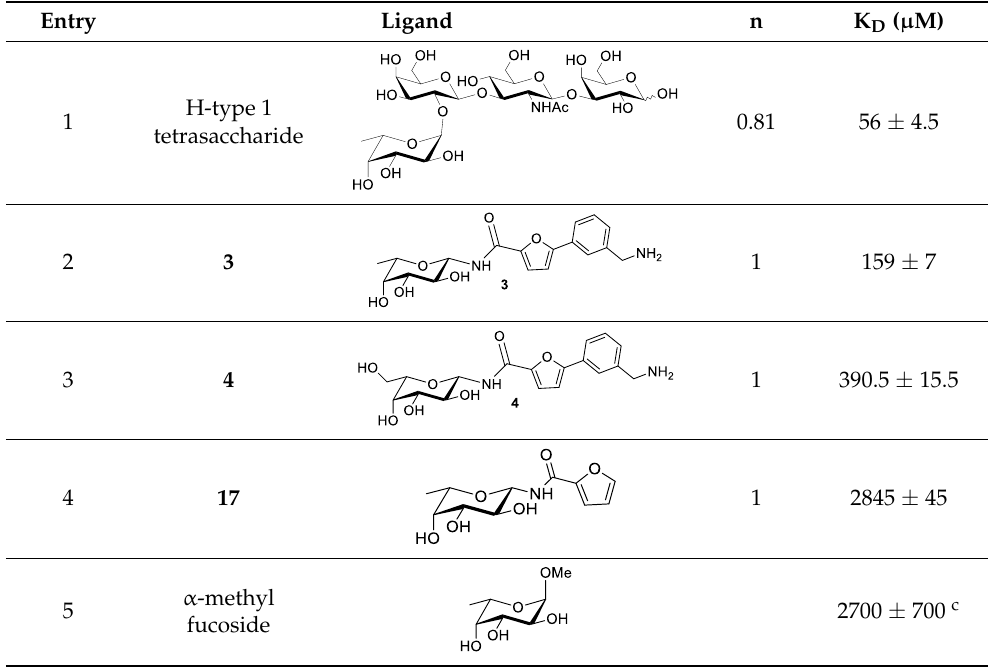
Table 1. Affinity of carbohydrate ligands of BC2L-C-Nt a,b .